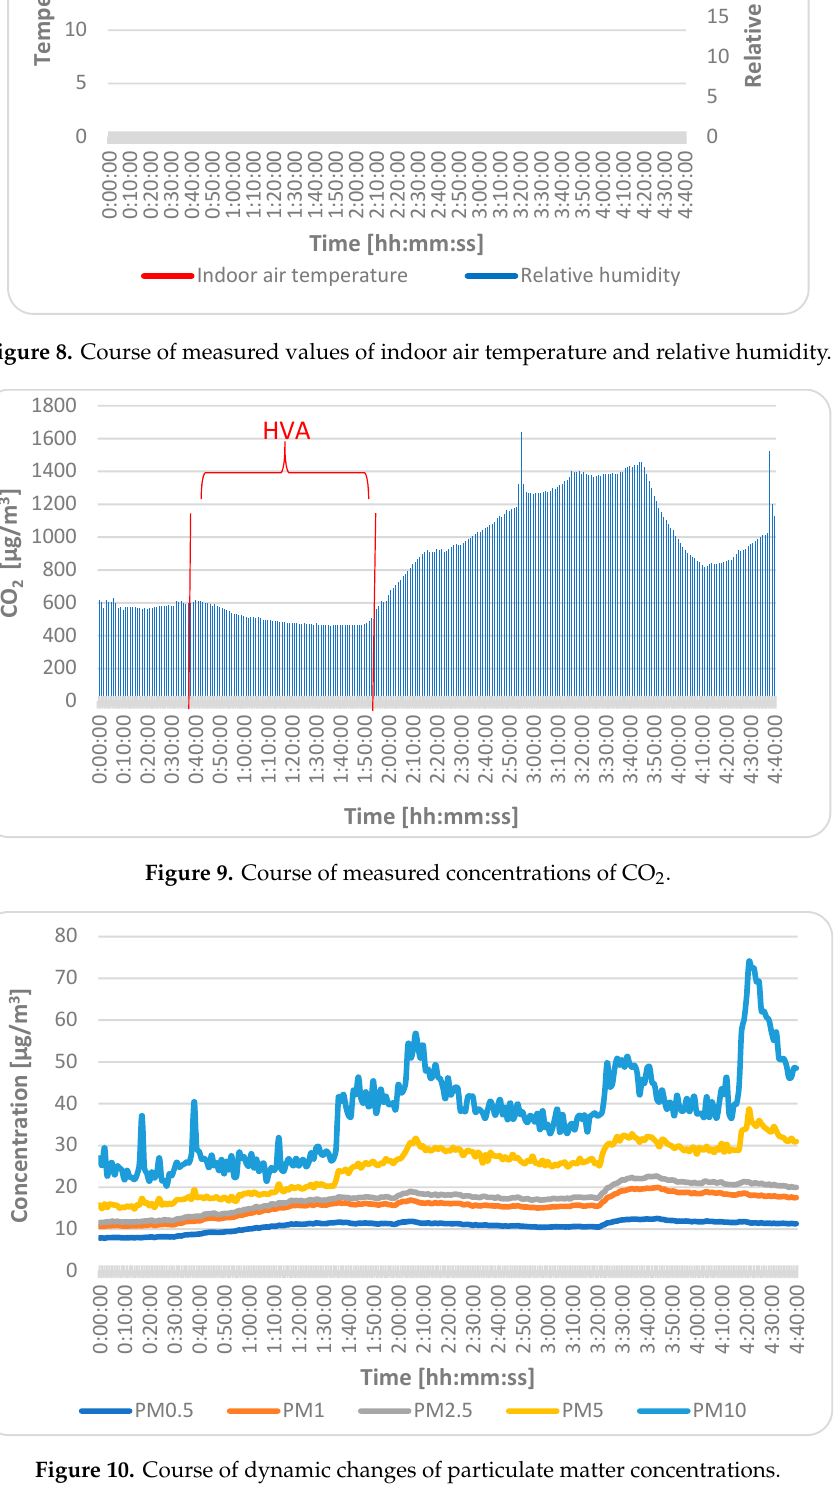
Figure 10. Course of dynamic changes of particulate matter concentrations.